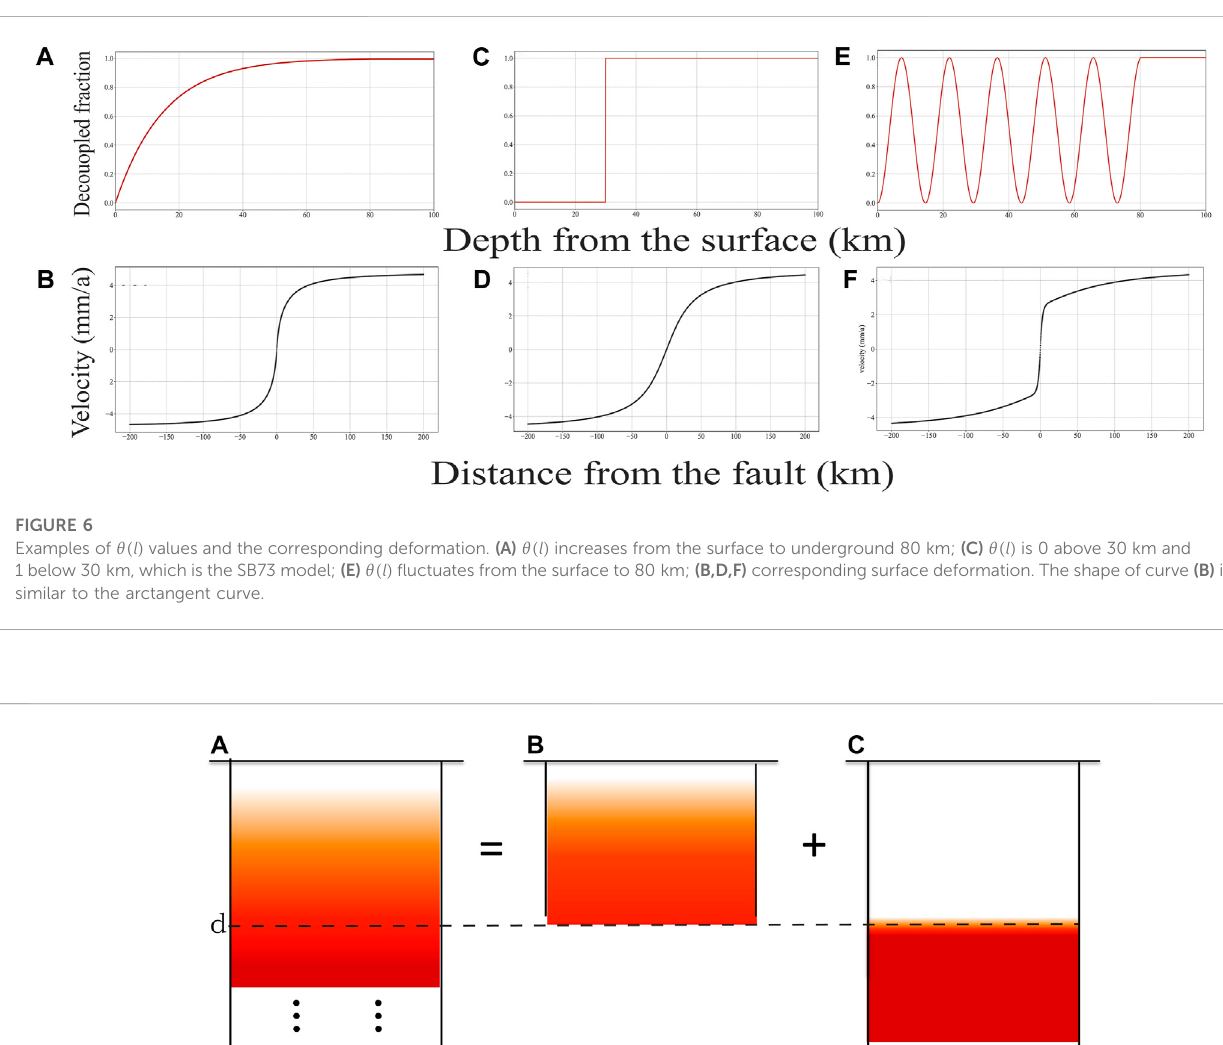
Frontiers in Earth